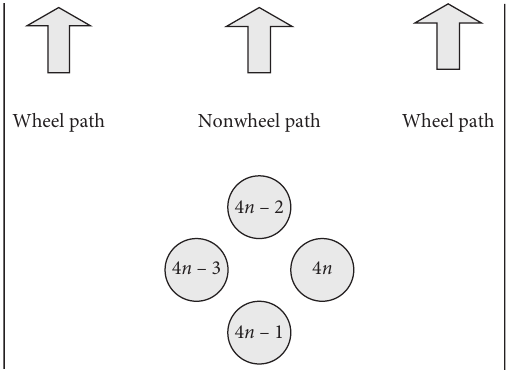
Figure 1: Core distribution in a transverse